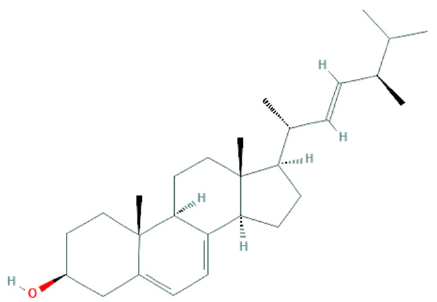
Figure 2. Ergosterol (C 28 H 44 O). Chemical structure obtained from PubChem database 4 August 2021 (https://pubchem.ncbi.nlm.nih.gov/compound/444679#section=2D-structure).